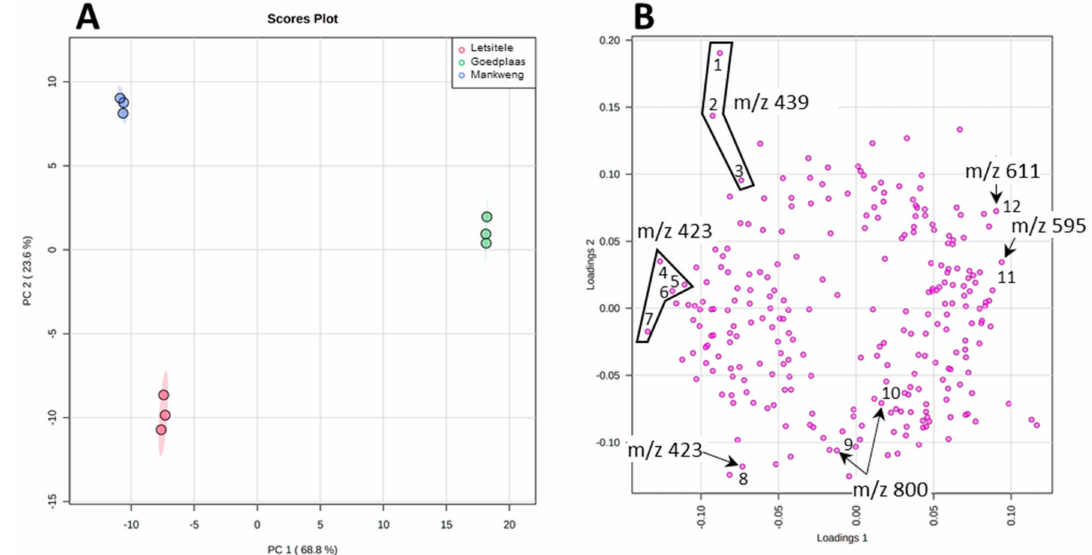
Figure 4. The PCA scores ( A ) and loading ( B ) plot of the three chemotypes. The numbers refer to the boxplots of each specific features illustrated in Figure